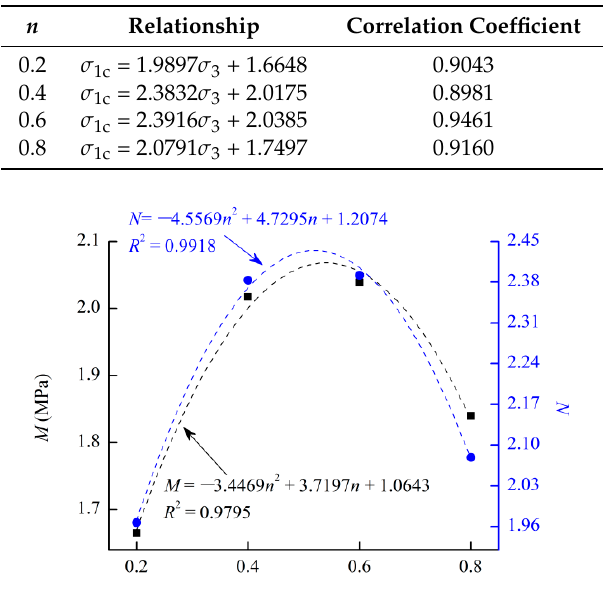
Figure 12. Relationship between the strength parameter and Talbot index of CPB specimens. Table 7. Relationship between the strength parameter and Talbot index. Parameter